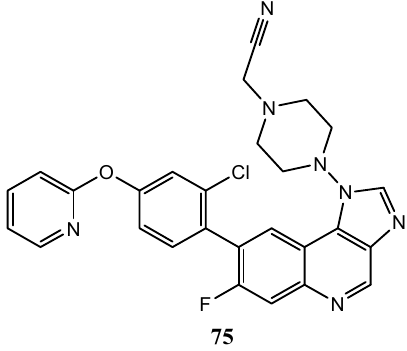
Figure 39. Structure of MEK inhibitor 1 H -imidazo[4,5- c ]quinoline 75 .